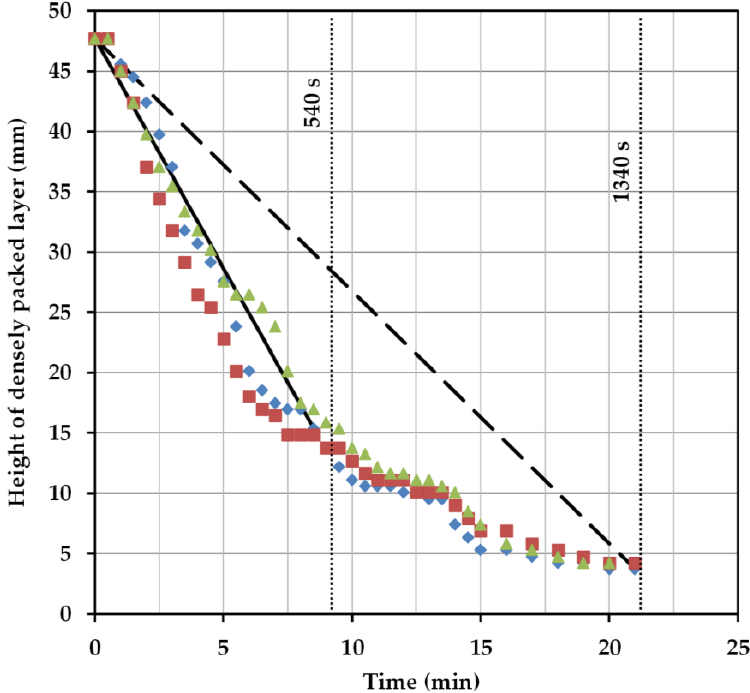
Figure 7. Height of the densely packed layer from triplicate batch-settling experiments (red, green, blue) as well as from the calculated separation rates (straight lines).